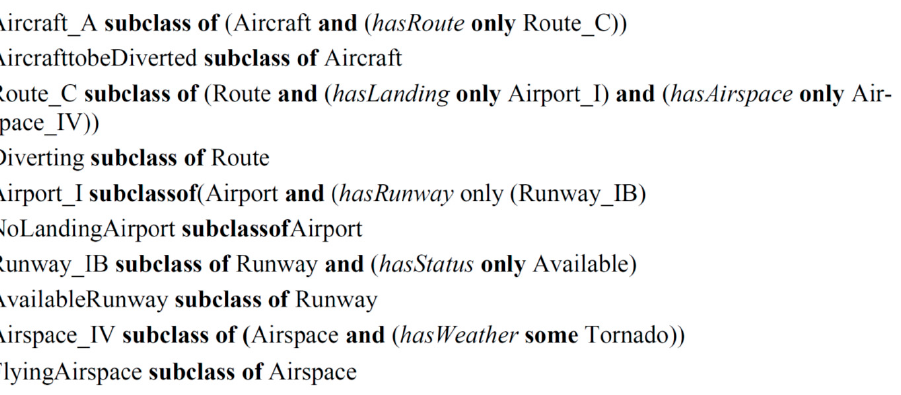
Figure 5. Examples of Terminological axioms ( TBox ) from the AAO.